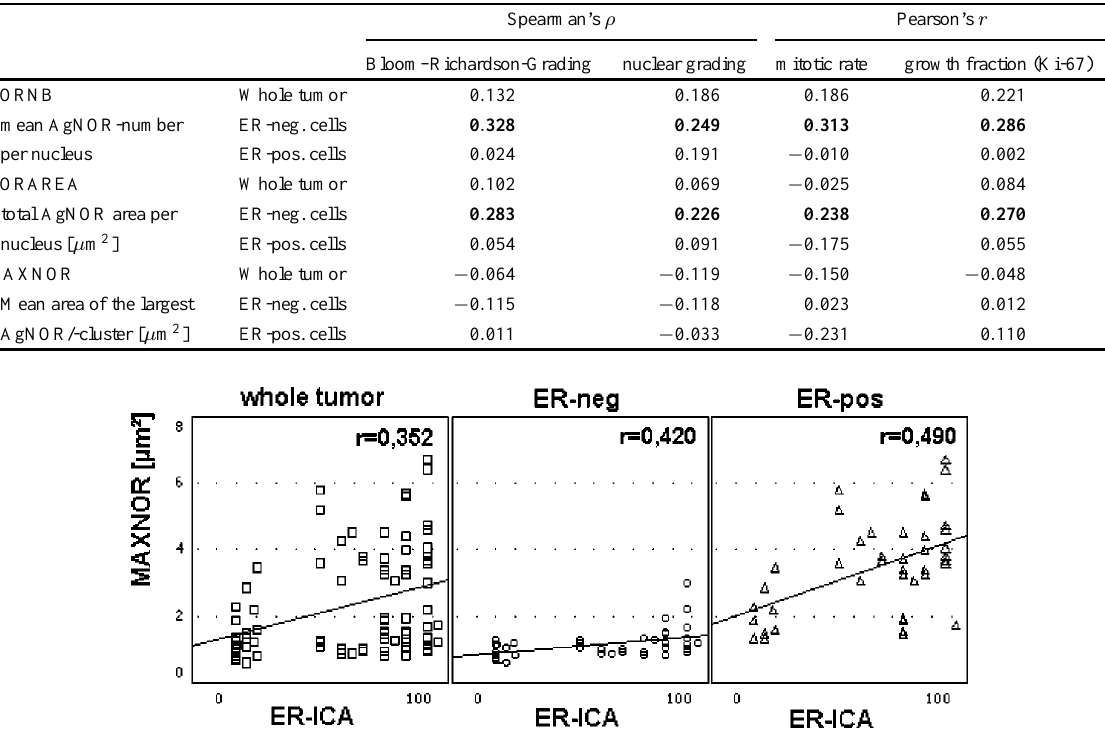
Fig. 6. Correlation between mean area of the biggest AgNOR/AgNOR-cluster per nucleus [ (cid:22) m 2 ] (MAXNOR) and Estrogen- Receptor-Immuno-Cytochemical-Assay (ER-ICA) [%] plotted for the whole tumor (left), ER-negative cells (middle) and ER-positive cells